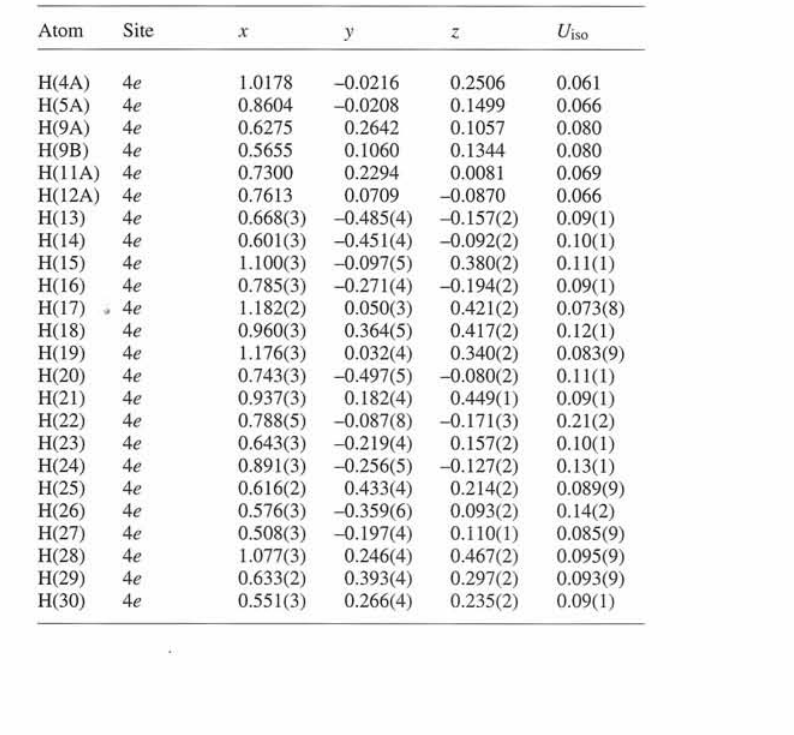
Table 2. Atomic coordinates and displacement parameters (in